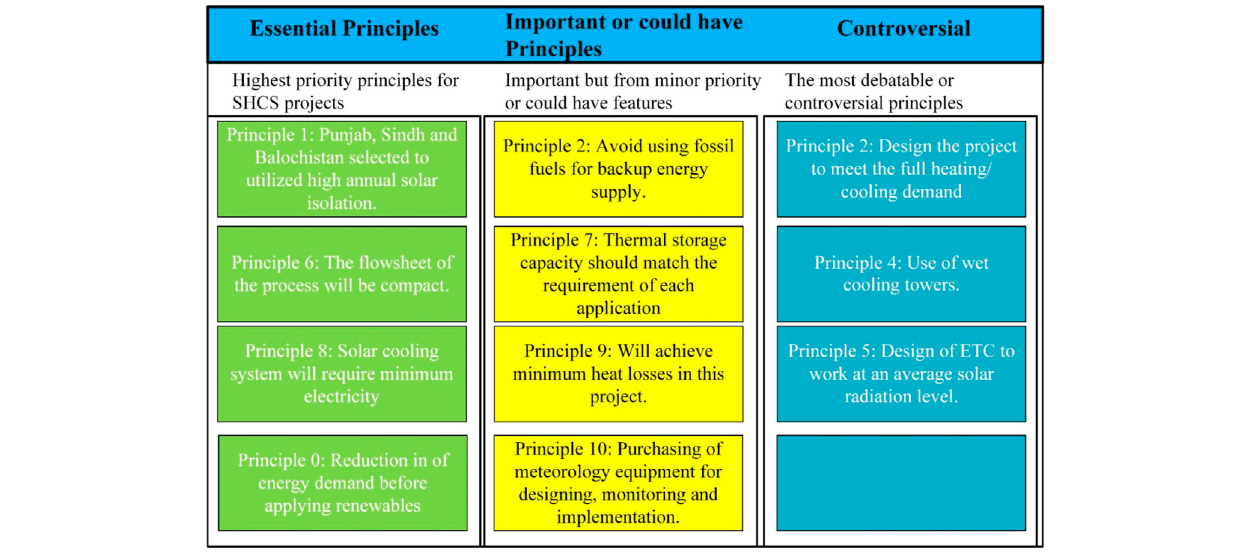
Frontiers in Energy Research |